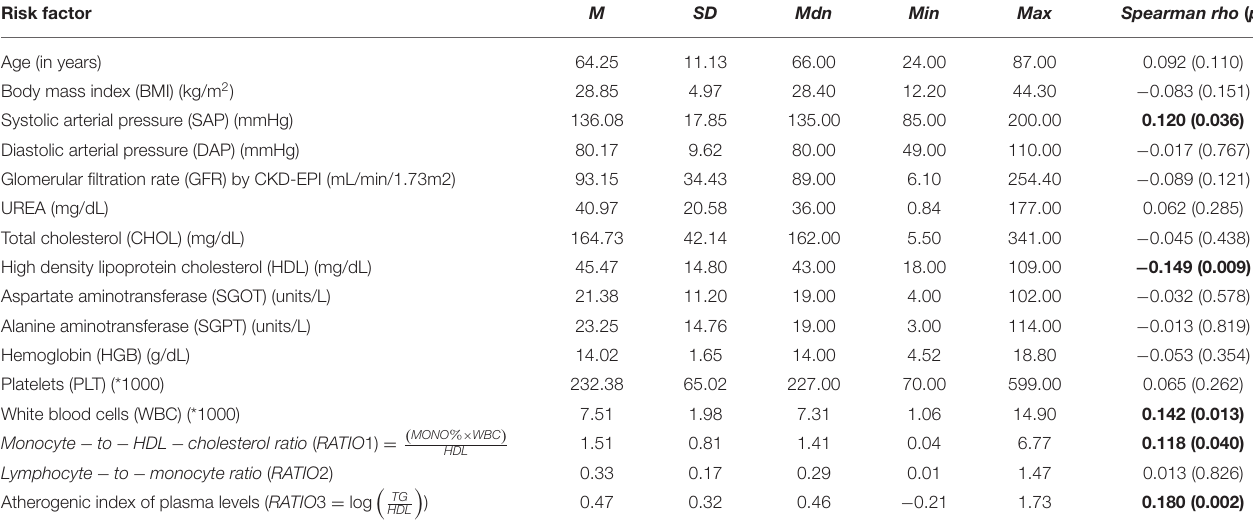
TABLE 4 | Descriptive and exploratory analyses for continuous risk factors and SYNTAX score. Risk factor